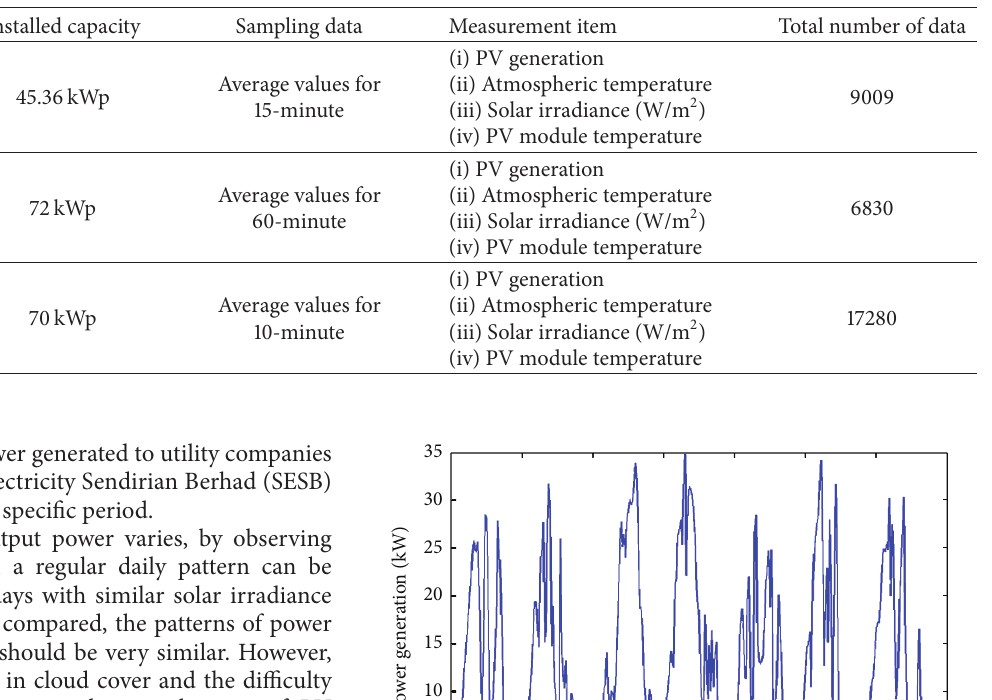
Table 1: PV database utilized in this study.